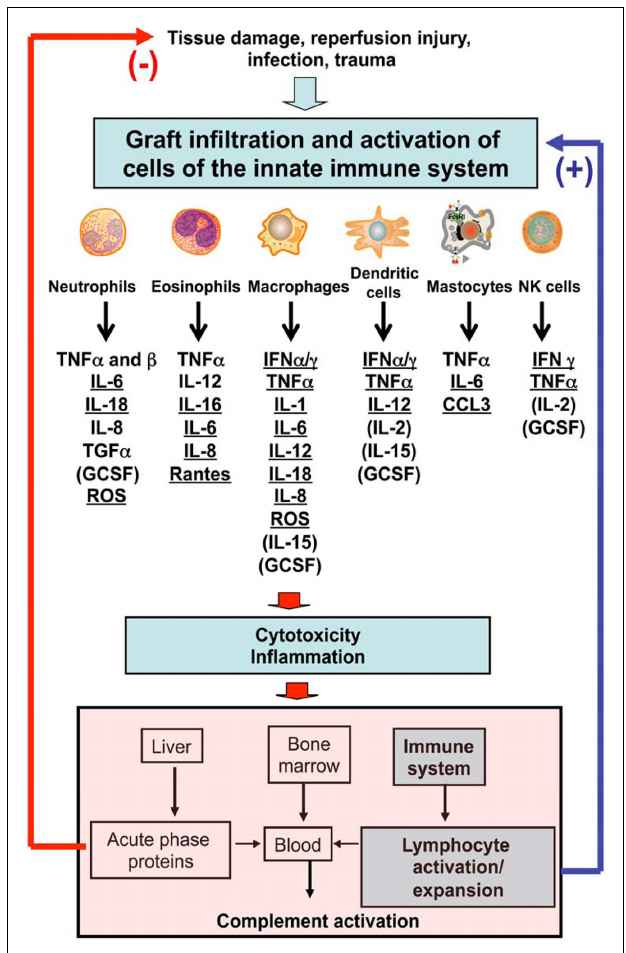
FIGURE 1 | Leukocytes and major cytokines involved in the innate immune response after